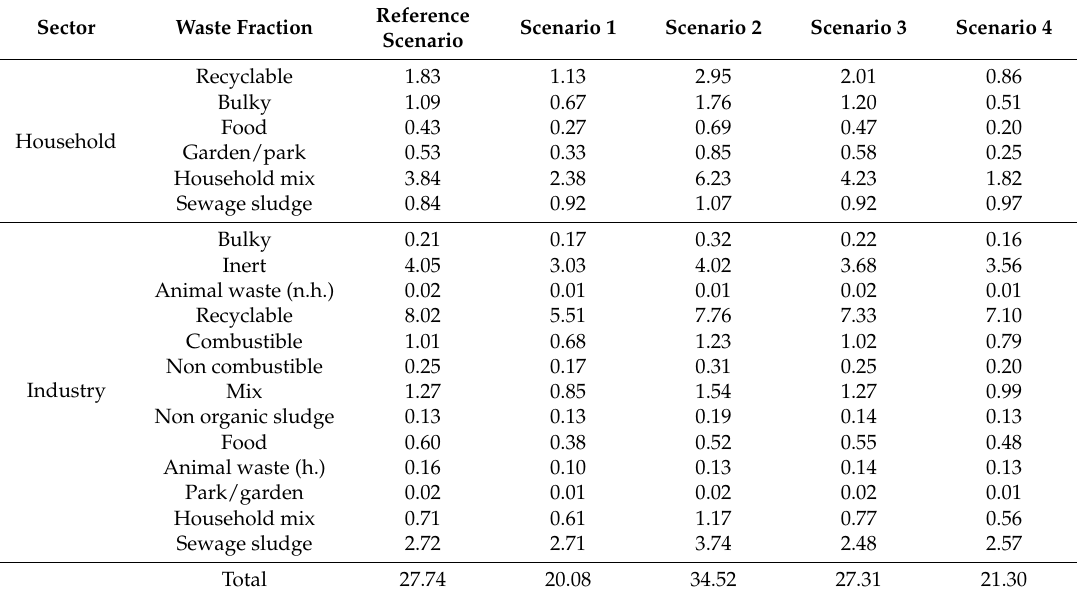
Table 1. Waste amounts per waste flow type in different scenarios without any policy instruments, Mtonne